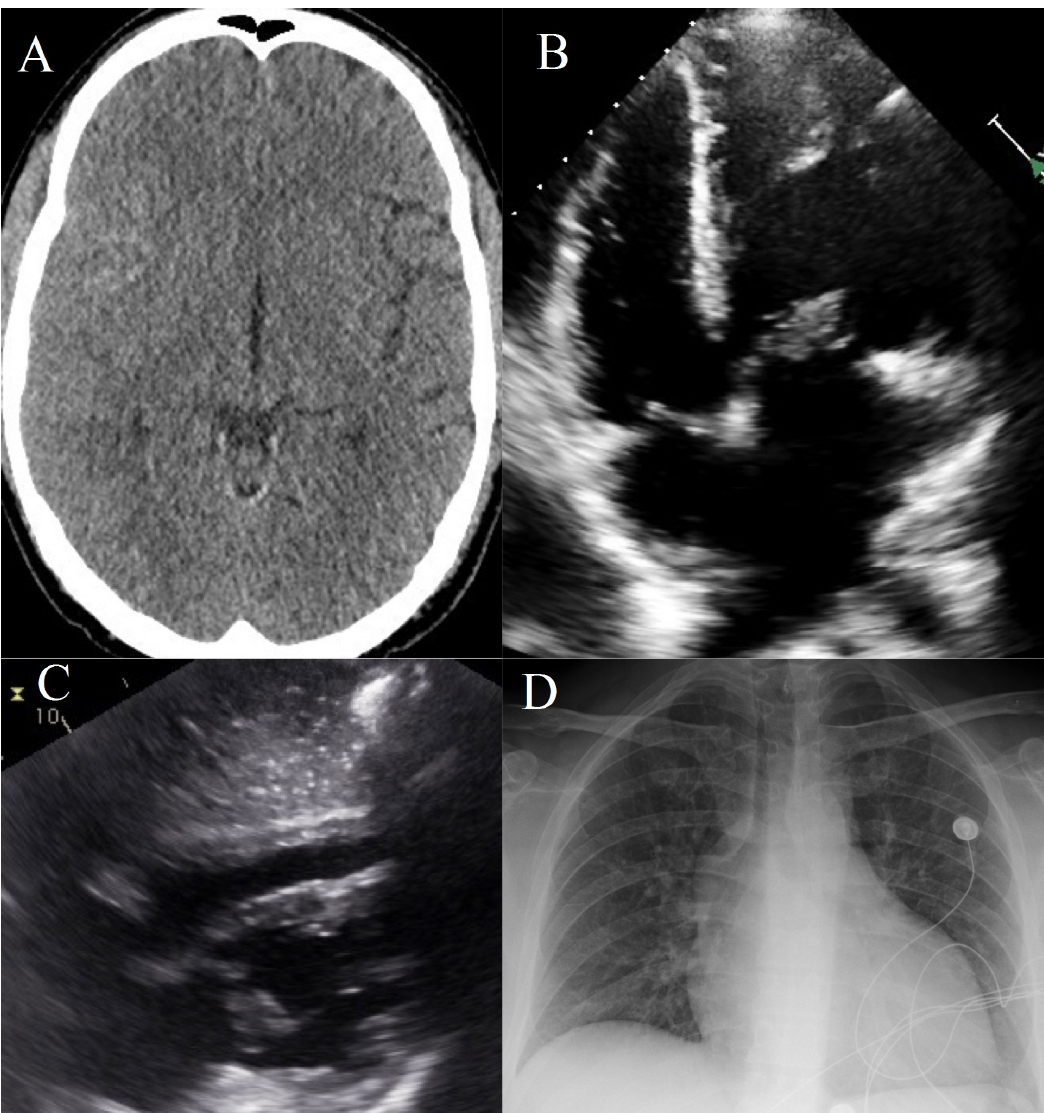
Figure 1. A composite image of radiographic and ultrasonographic findings from this case. ( A ) A coronal view of an obliterated right Sylvan Fissure due to hemorrhage from a ruptured mycotic aneurysm on head CT scan; ( B ) A tricuspid valve with an infective vegetation on echocardiogram; ( C ) An echocardiogram showing transposition of the great vessels with congenital correction resulting in atrio-ventricular discordance; ( D ) A chest X-ray showing the patient’s abnormal cardiac silhouette.